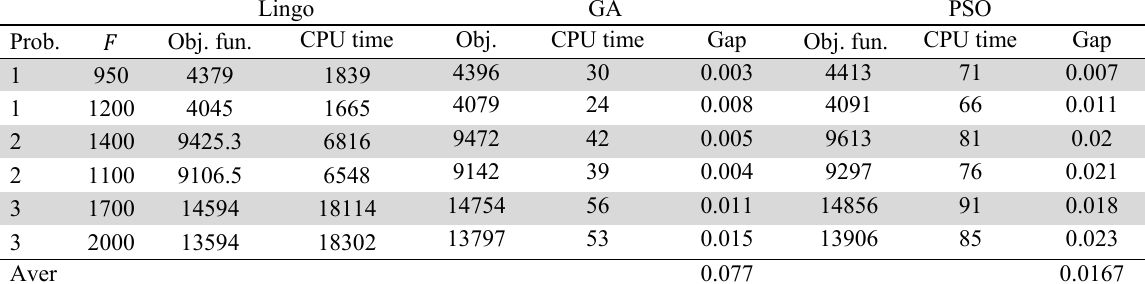
The results of the implementation of a mixed integer programming, GA and PSO Lingo GA PSO Prob.